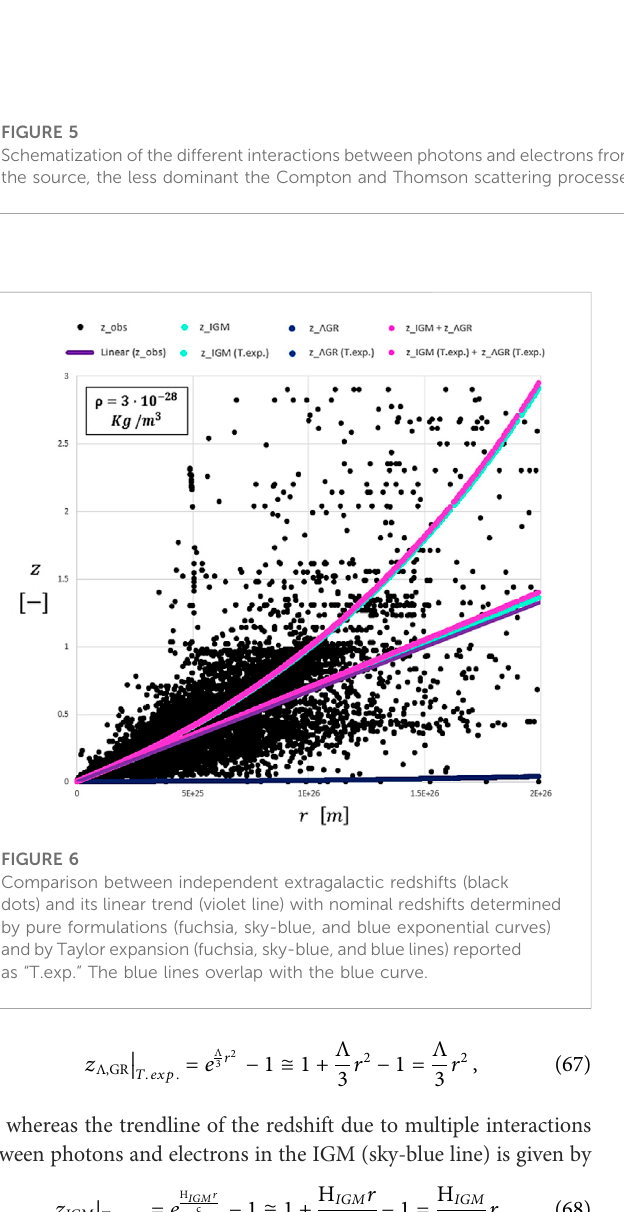
In order to have a better awareness of the units, 1E+26 m corresponds to 3.24 Gpc (or 10.5 Gly). As explained, the violet line represents the linear trend of the observational redshift measurements (black dots), and it is accordingly compared with the Einsteinian redshift approach by means of a FLRWT metric and the contribution of the transit redshift (fuchsia line). It is also possible to identify its exponential trend (fuchsia curve).